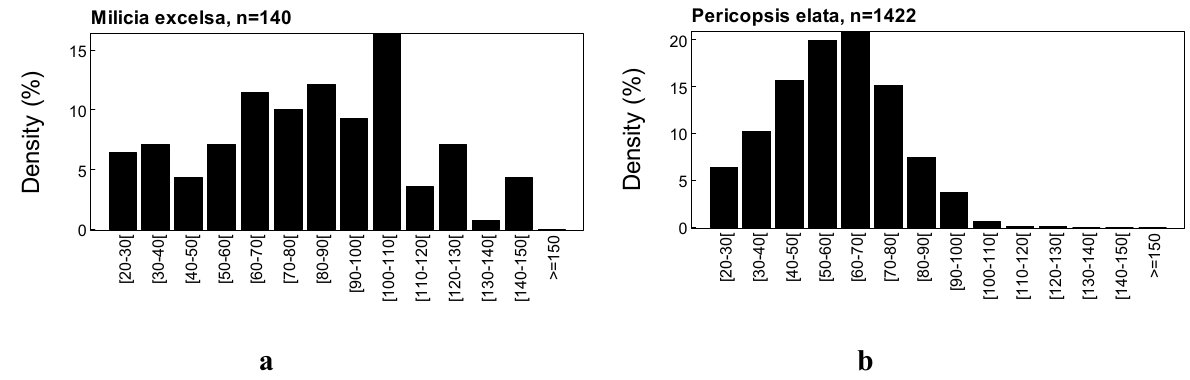
a b Figure 1. Diameter distribution of M. excels ( a ) and of P. elata ( b ) in the forest management units managed by the Pallisco logging company in south-eastern Cameroon. Each tree